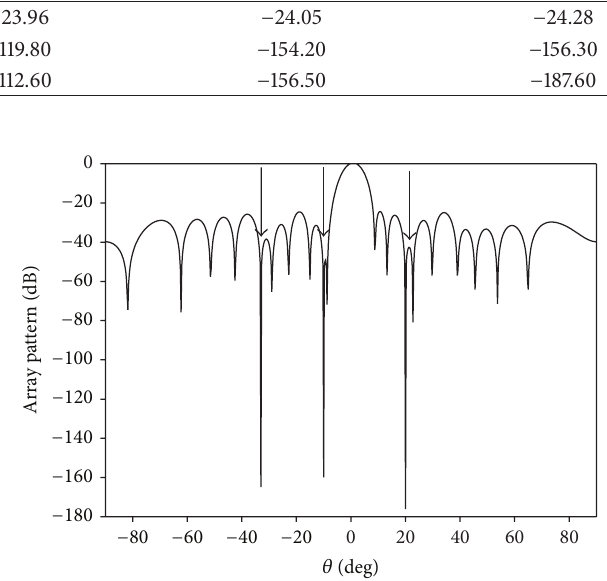
Figure 11: Radiation pattern found by phase only control with triple null at − 33 ∘ , − 10 ∘ , and 20 ∘